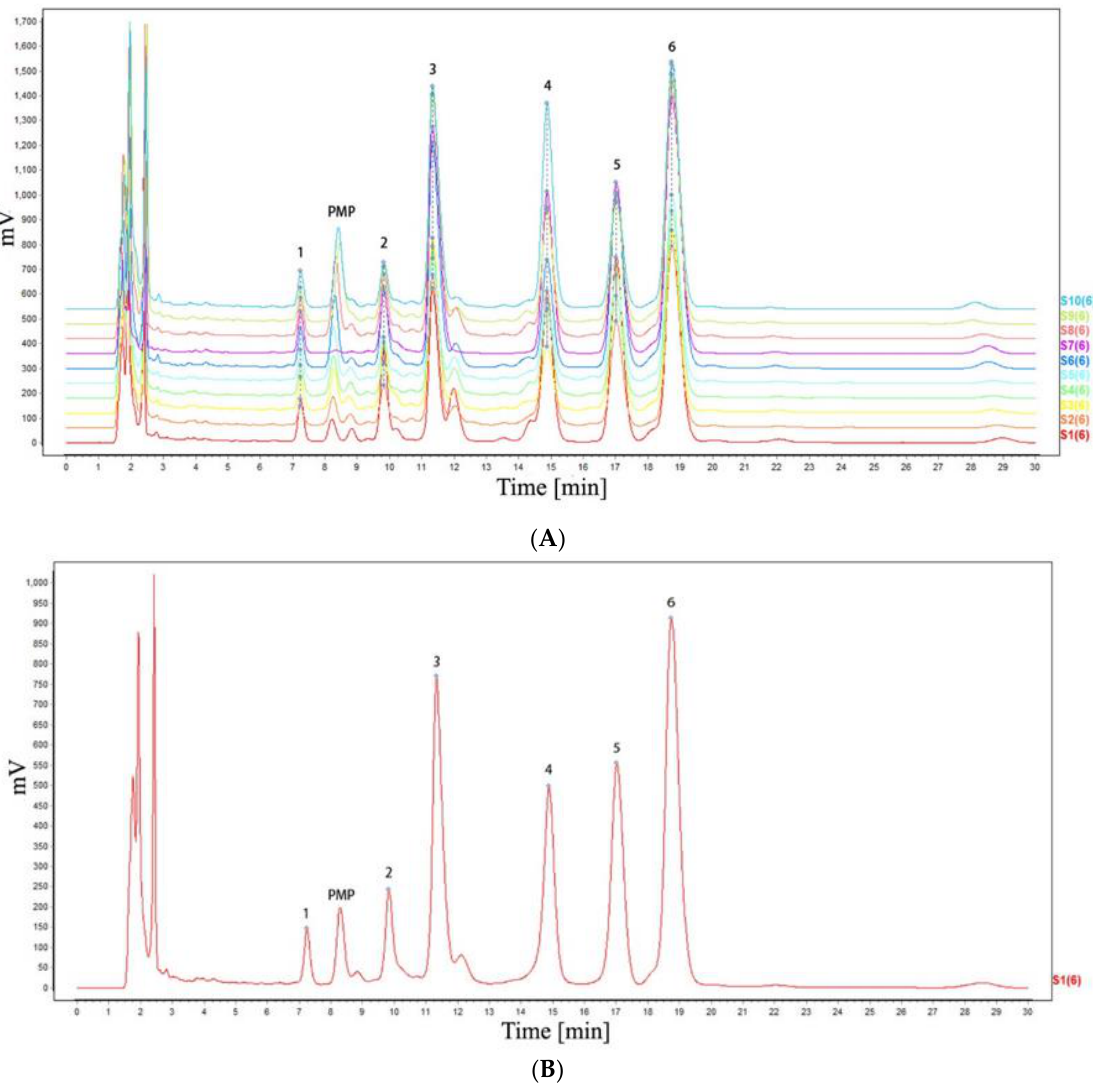
Figure 1. The PMP-HPLC fingerprints. ( A ) the PMP-HPLC fingerprints of different SPs ( B ) the PMP-HPLC standard referential fingerprint of SPs.